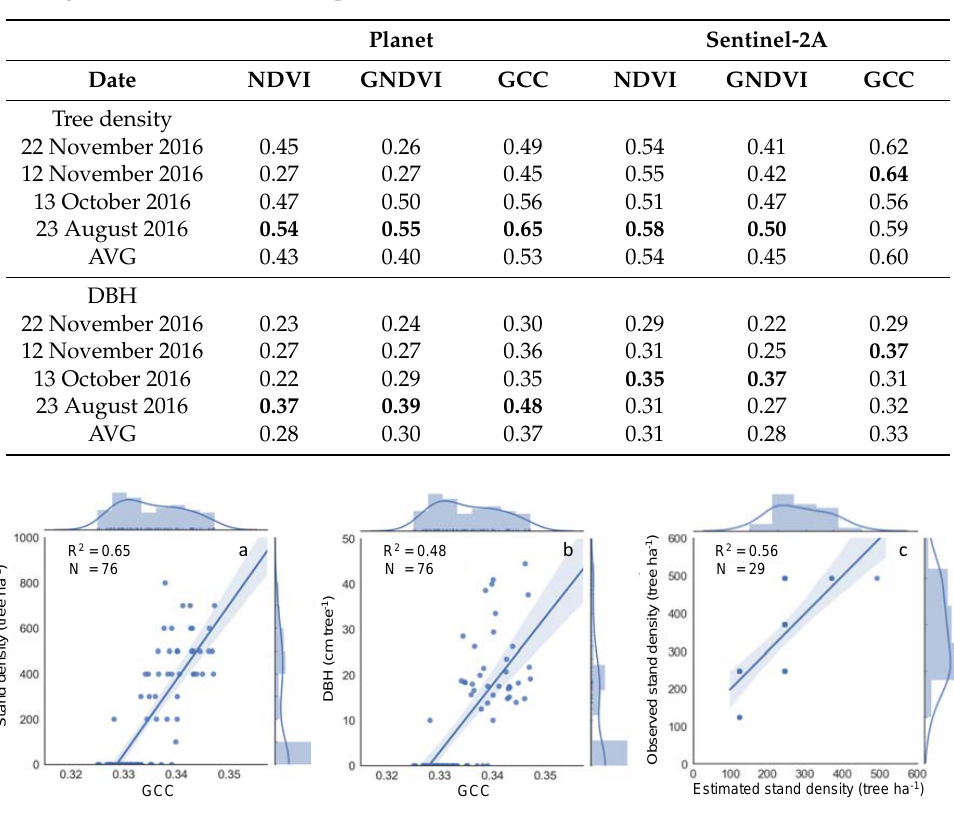
Figure 4. ( a , b ) Scatterplots of GCC derived from Planet in 23 August 2016 vs. field ‐ measured stand density and DBH. ( c ) Estimated vs observed stand density, using the GCC calibrated linear fit (from a ) and stand count in a nearby area. Note that in ( c ), some of the 29 plots have the same value. We then used the GCC calibrated stand density and DBH equations to derive the satellite ‐ based stand density and DBH maps.